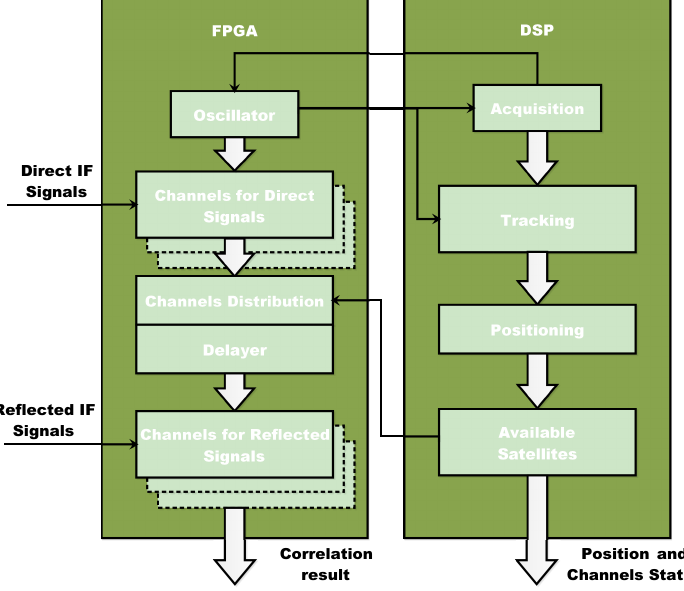
Figure 5. Connection between FPGA and